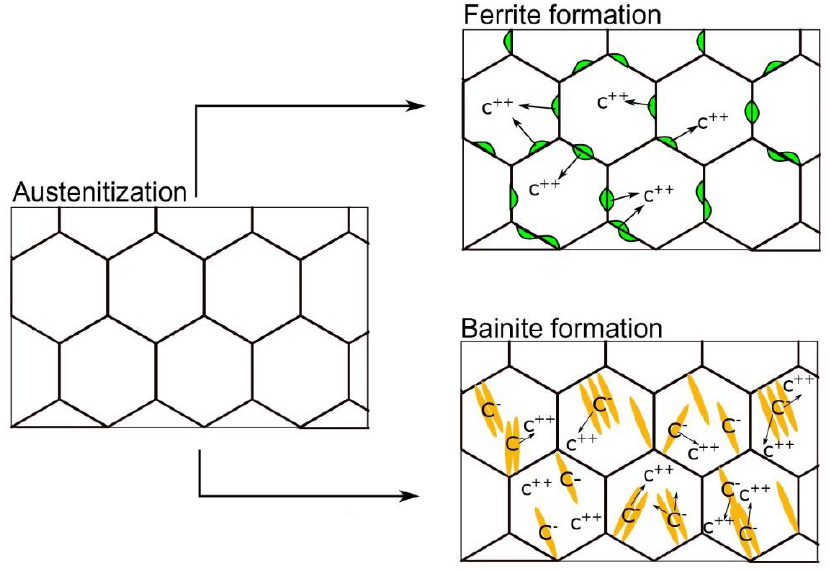
Figure 10. Schematic representation of carbon enrichment of the austenite during coiling and bainite